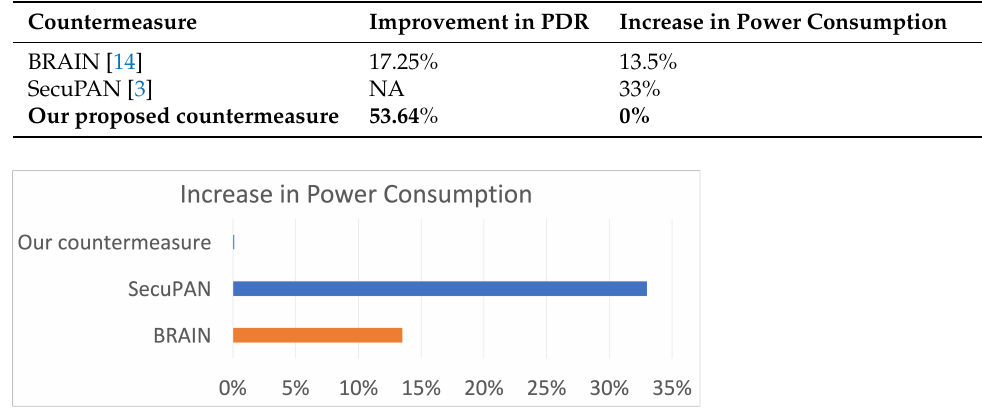
Figure 22. Increase in power consumption compared to normal